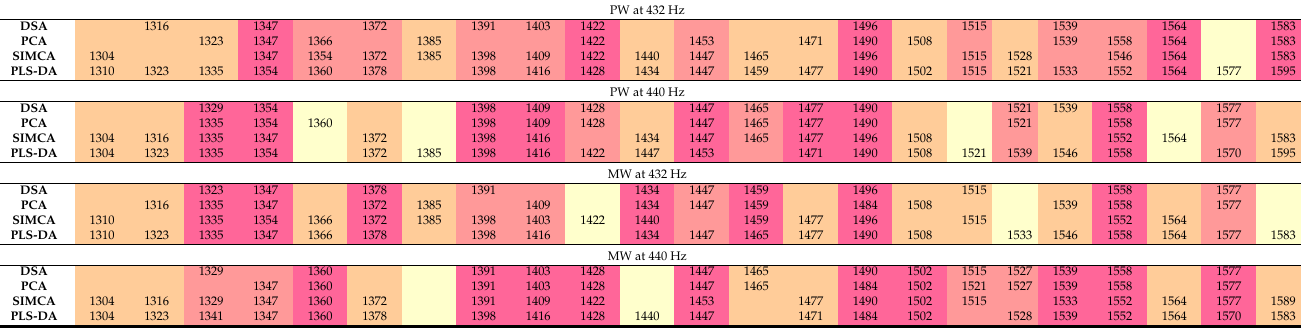
Table 3. WABs seen activated through analyses in the region 1300–1600 nm. From lighter to darker (yellow to red) color, repeatability of the same band increases in the displayed 4 datasets. Consistent common bands were found at 1335–1347 nm, 1391–1403 nm, 1409–1416 nm, 1422–1427 nm, 1447 nm, 1484–1496 nm and 1552–1558 nm for sound perturbation, while specific bands were distinguished according to the frequencies and water